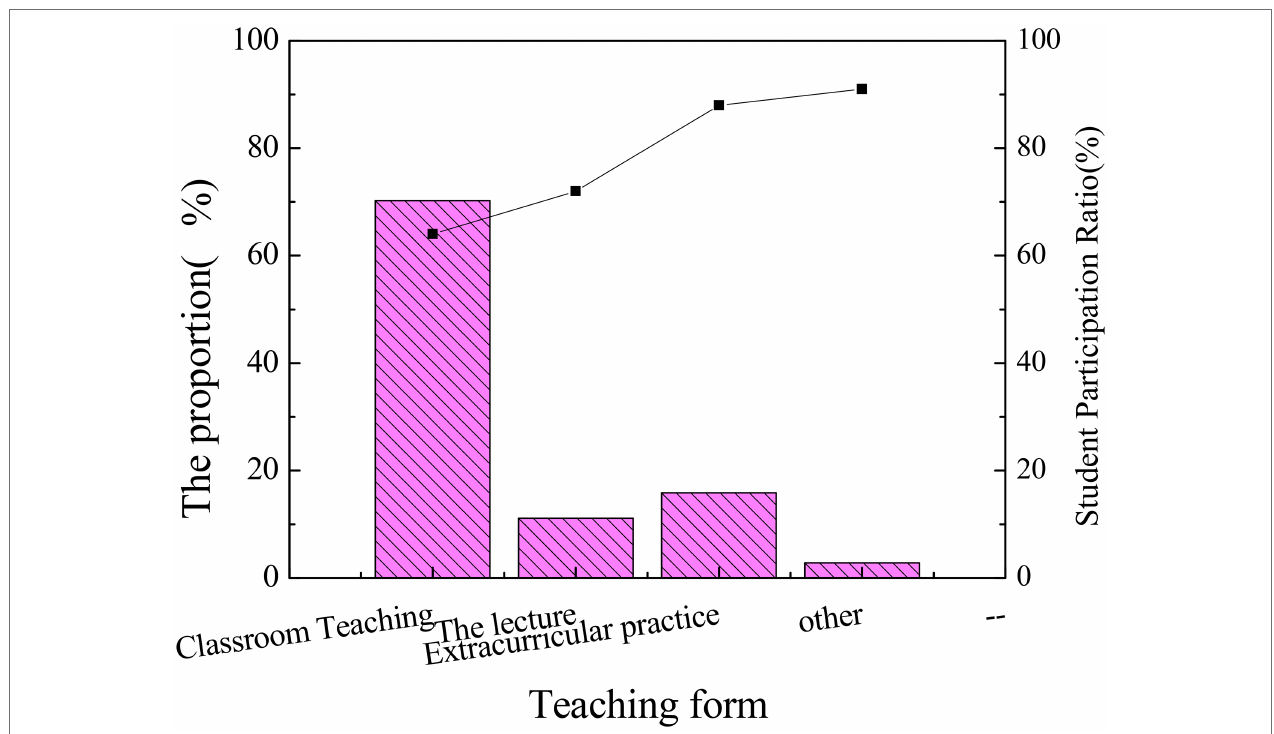
FIGURE 5 | Statistics of main teaching patterns and students’ participation in entrepreneurship education.